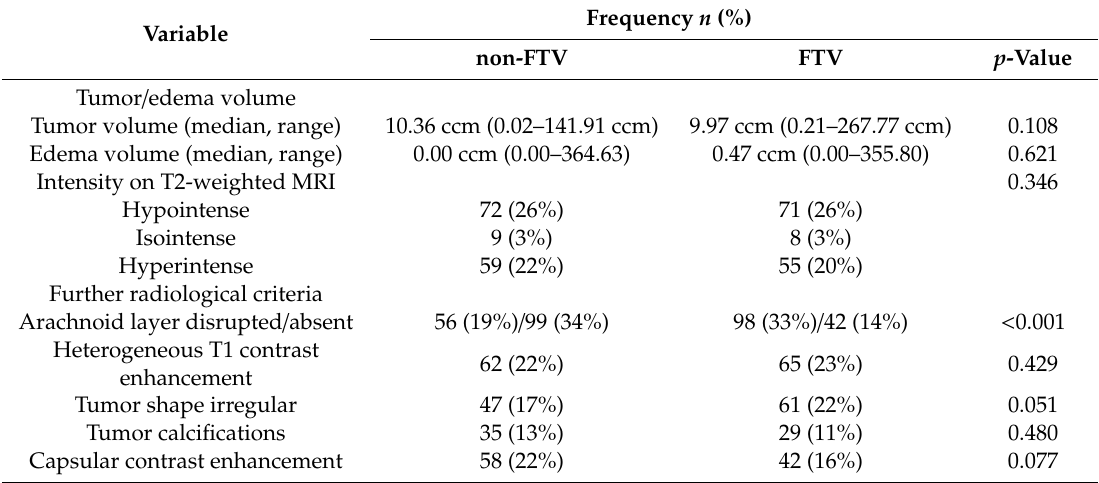
Table 3. Correlations between the occurrence of fibrotic tumor vessels (FTV) and radiological variables.